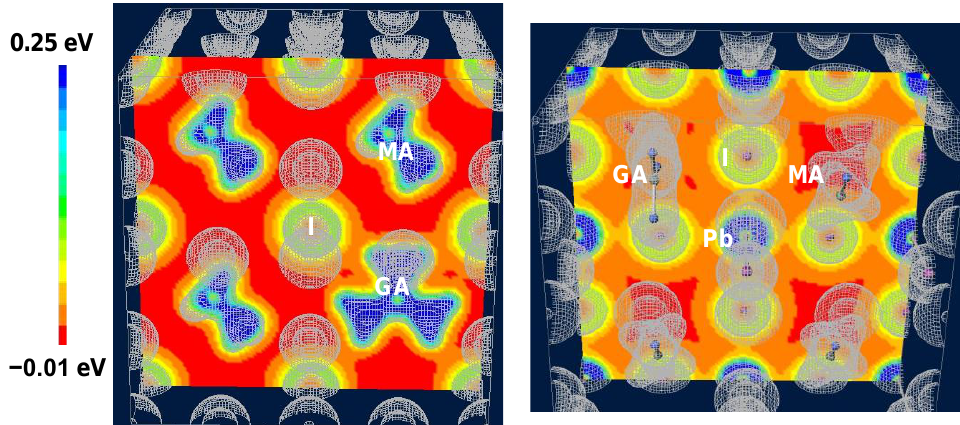
0.875 GA 0.125 PbI 3 .